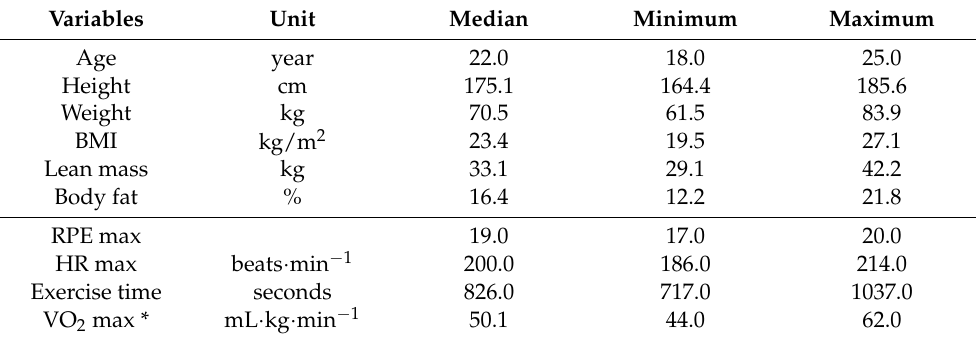
Table 1. Baseline characteristics of the participants in the cross-over study. Variables